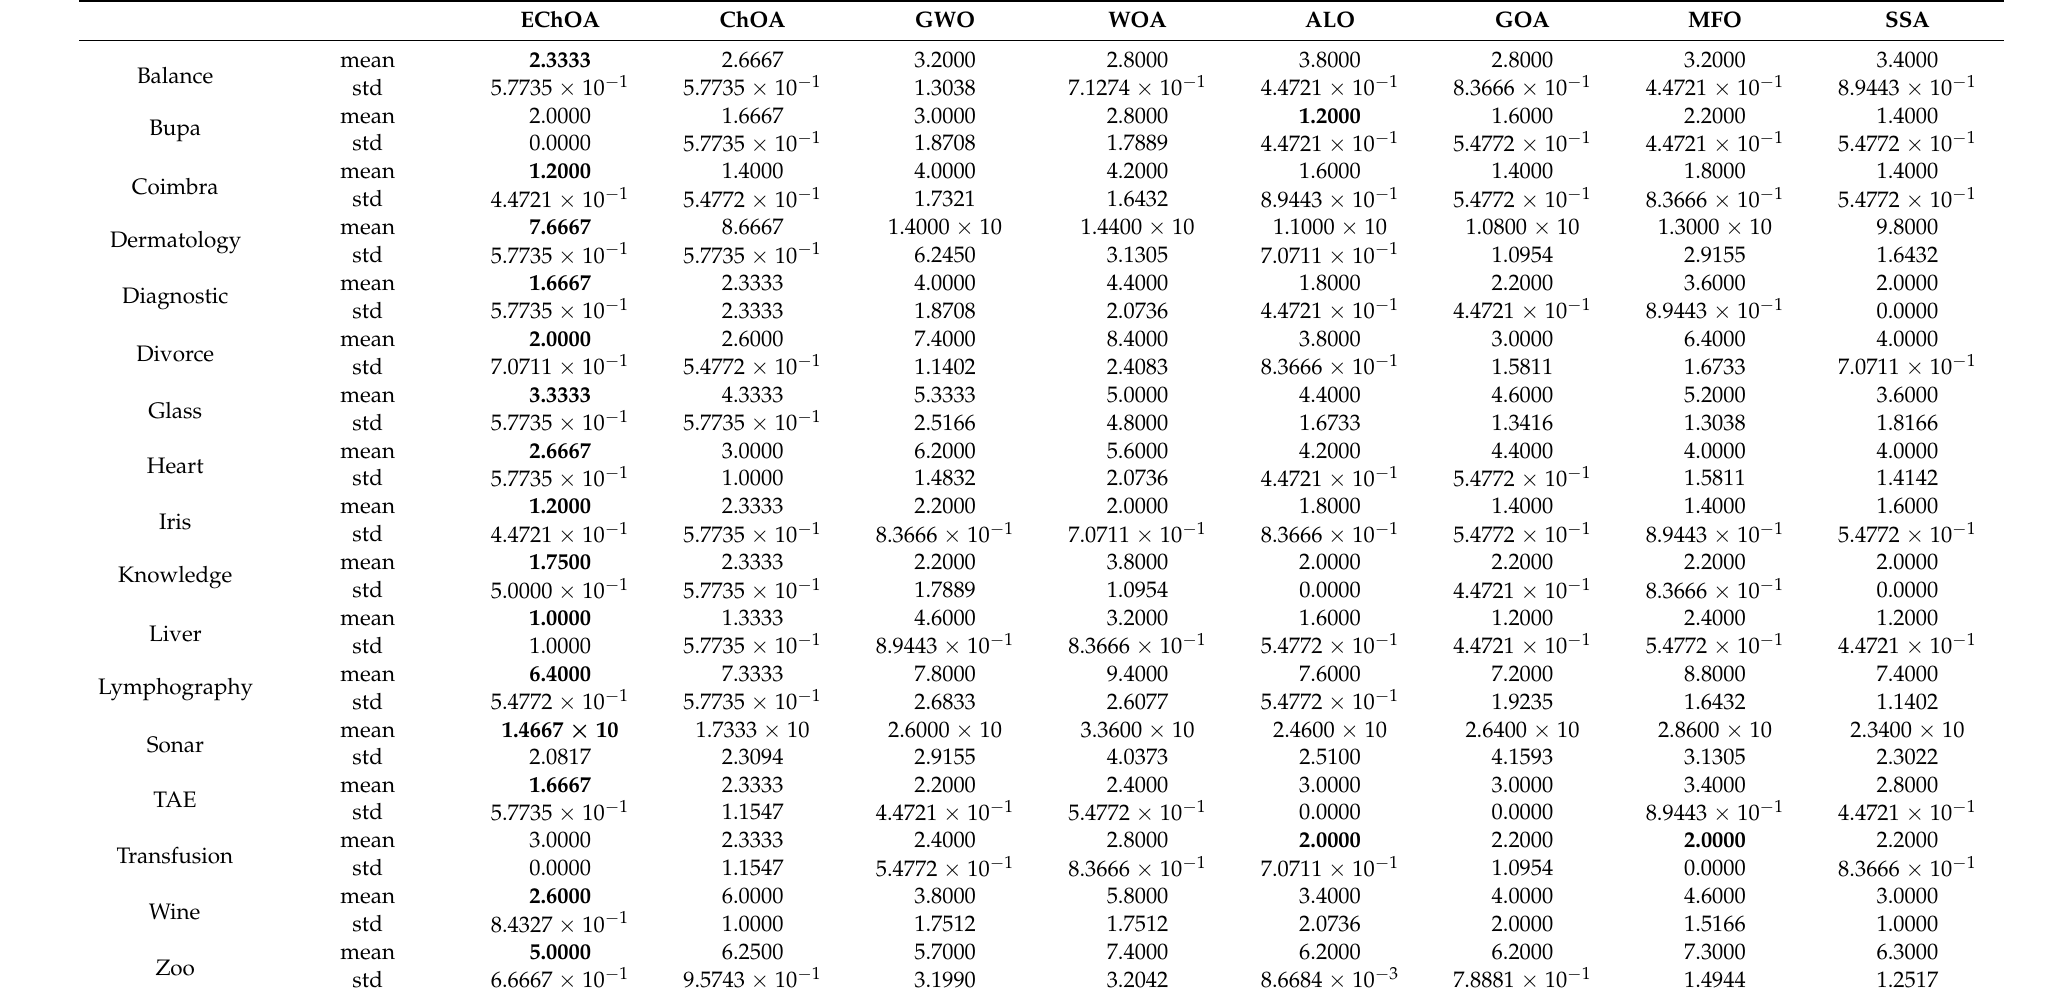
Table 4. Mean and standard deviation of the number of features for all data sets with applying feature